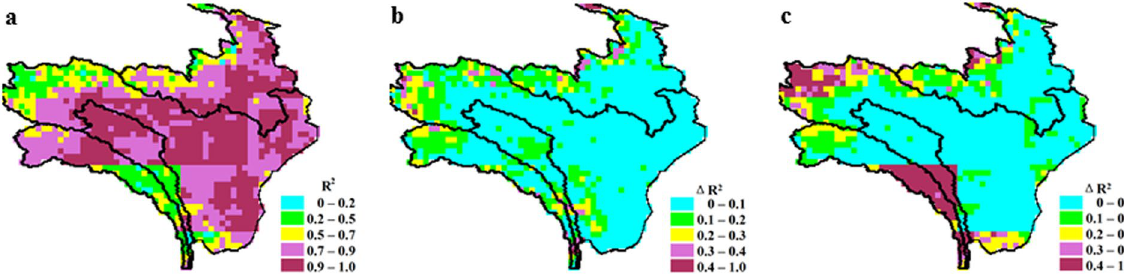
Figure 2. Contributions of water balance components to Q annual variation for eastern TP region shown in Fig. 1 for 2003–2014. ( a ), the coefficient of determination (R 2 ) when only P is used to estimate Q variation. ( b ), additional R 2 when ET together with P is used for estimating Q variation. ( c ), additional R 2 when Δ TWS together with P is used for estimating Q variation. The maps were generated using ENVI (v 4.5, https://www. harris.com/solution/envi) © 2017 Harris Corporation.